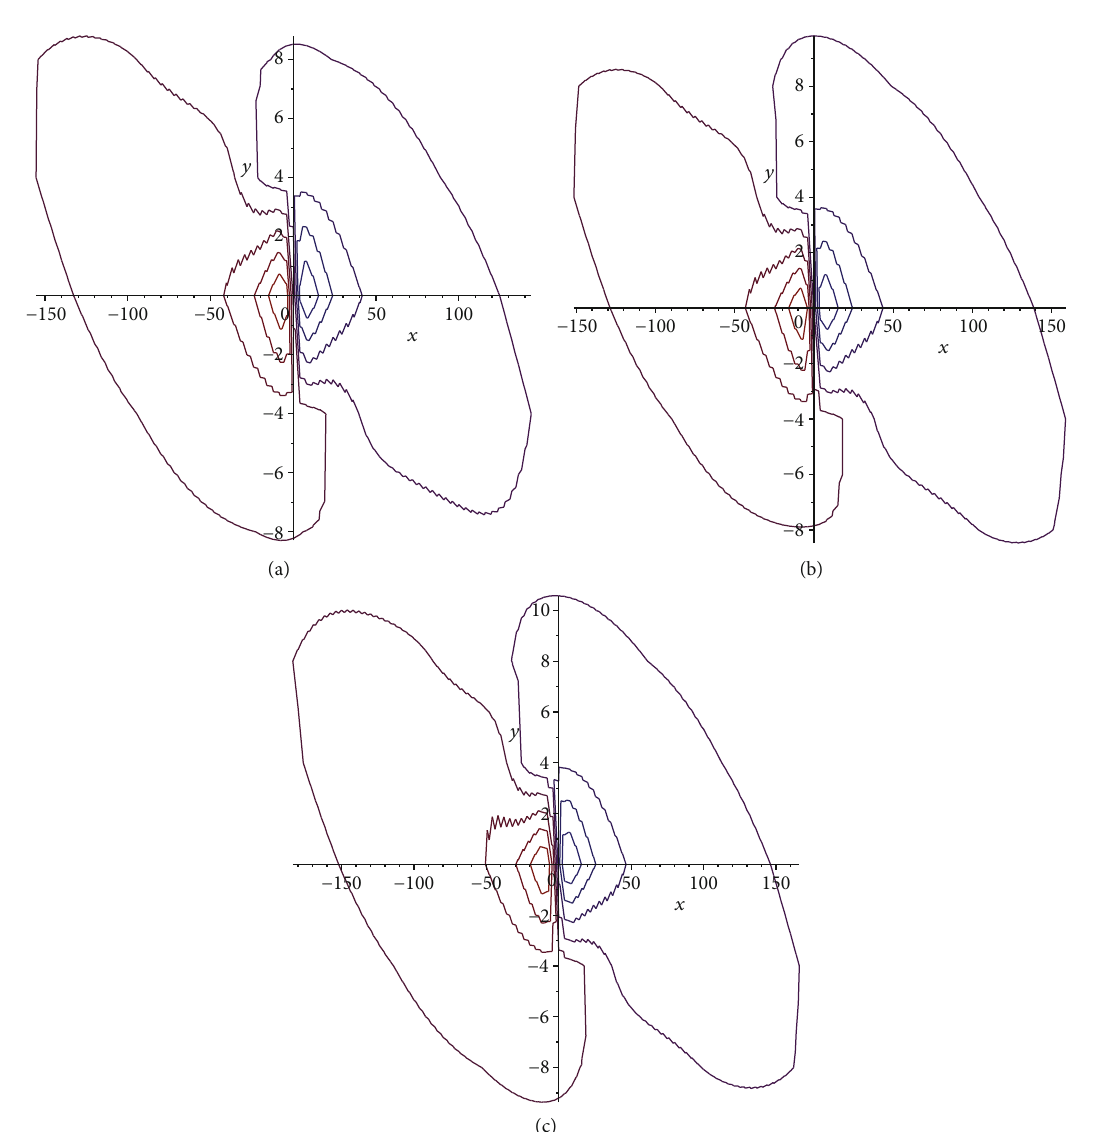
Figure 2: (Color online) soliton solution u with t = 0, 10, 30 : contour plots.